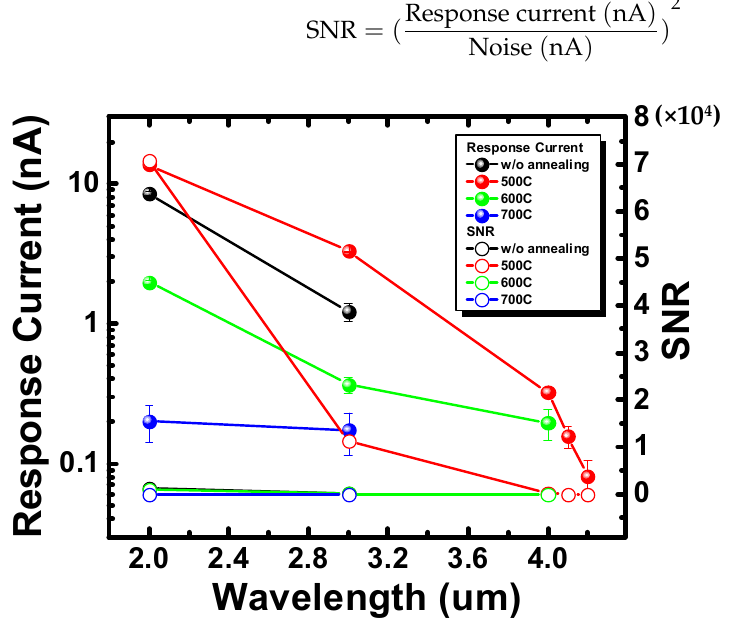
Figure 3. The response current and signal-to-noise ratio of devices with different annealing param- eters.